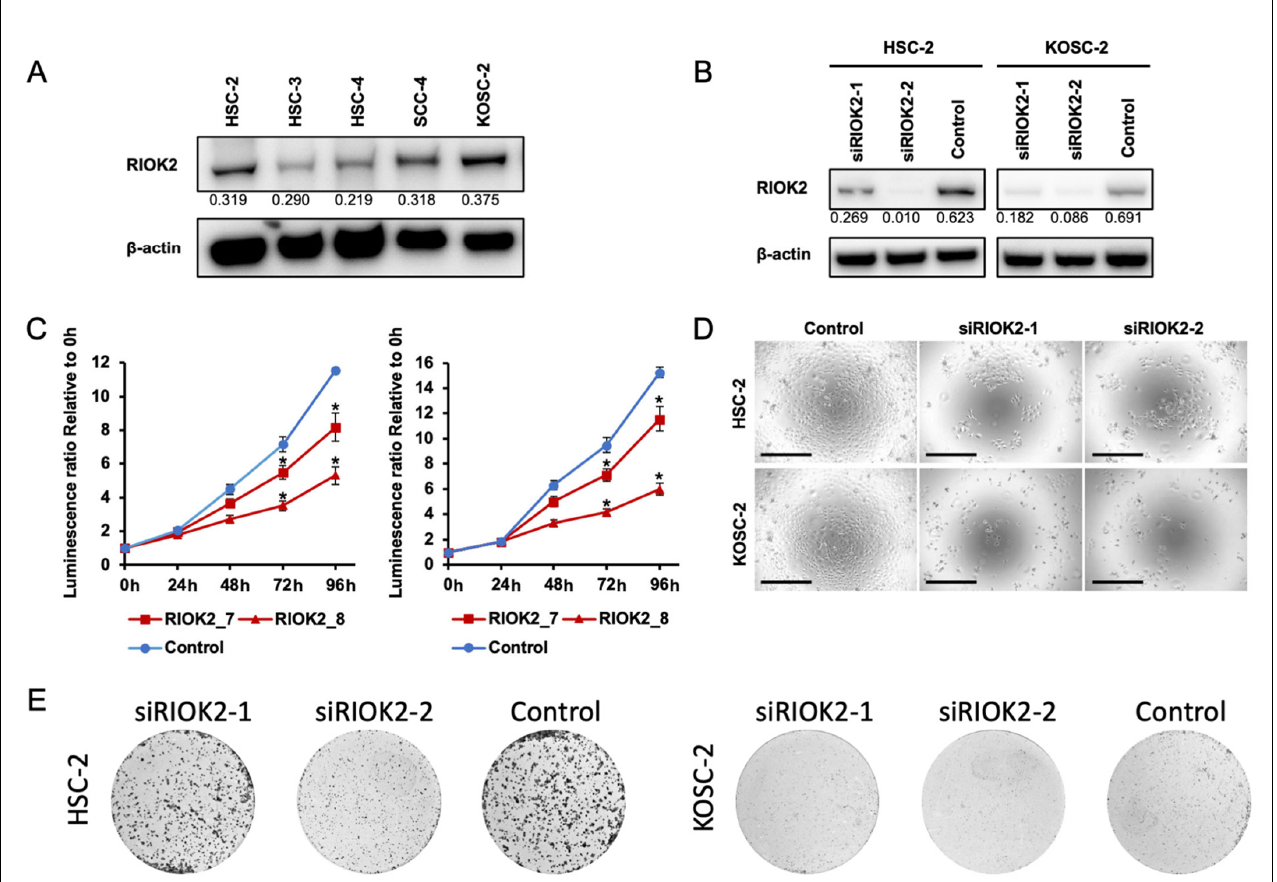
Figure 2. RIOK2 expression is involved in oral cancer cell growth. ( A ) Western blot analysis of RIOK2 expression was performed in two oral cancer cell lines transfected with siRIOK2 (siRIOK2-1, siRIOK2-2) and siRNA Control (control). Cell lysates were prepared 48 h (for KOSC-2) and 96 h (for HSC-2) after transfection. β -actin expression was blotted as a loading control. The densitometry intensity/reading ratio (RIOK2/ β -actin) is indicated under the band image. ( B ) Western blot analysis of RIOK2 expression in two oral cancer cell lines transfected with siRIOK2 (siRIOK2-1, siRIOK2-2) and siRNA Control (control). β -actin expression was blotted as a loading control. The densitometry intensity/reading ratio (RIOK2/ β -actin) is indicated under the band image. ( C ) Cell growth was evaluated in siRIOK2-1, siRIOK2-2, and Control OSCC cell lines (KOSC2, HSC2) at the indicated time points, and ( D ) representative photographs of transfected cells after 96 h of culture are shown. The scale bars indicate 500 µm. Optical densities at 490 nm were measured using plate reader. Welch’s t -test was used to assess statistical significance (* p < 0.05). Technical replicates, n = 6; biological replicates, n = 3. ( E ) Colony formation capacity was assessed using HSC-2 and KOSC-2 transfected with siRIOK2 and siRNA Control (control). Representative images are shown here. Technical replicates, n = 3, from two independent experiments.